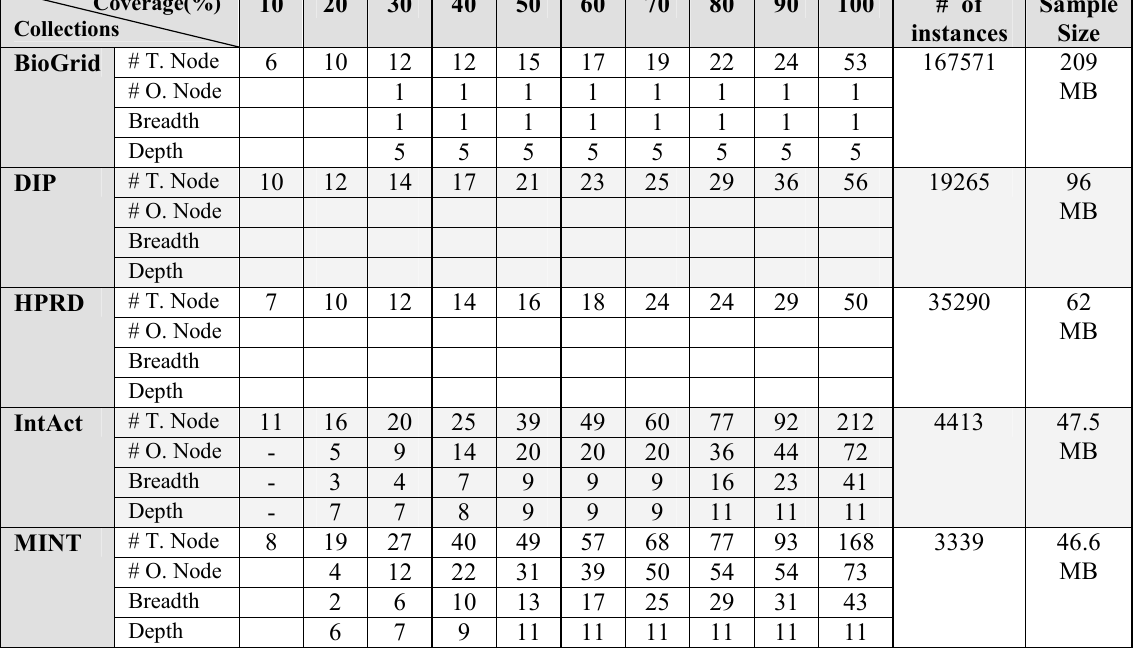
Table 2: Number of Total Nodes, and selected Optional Nodes in different